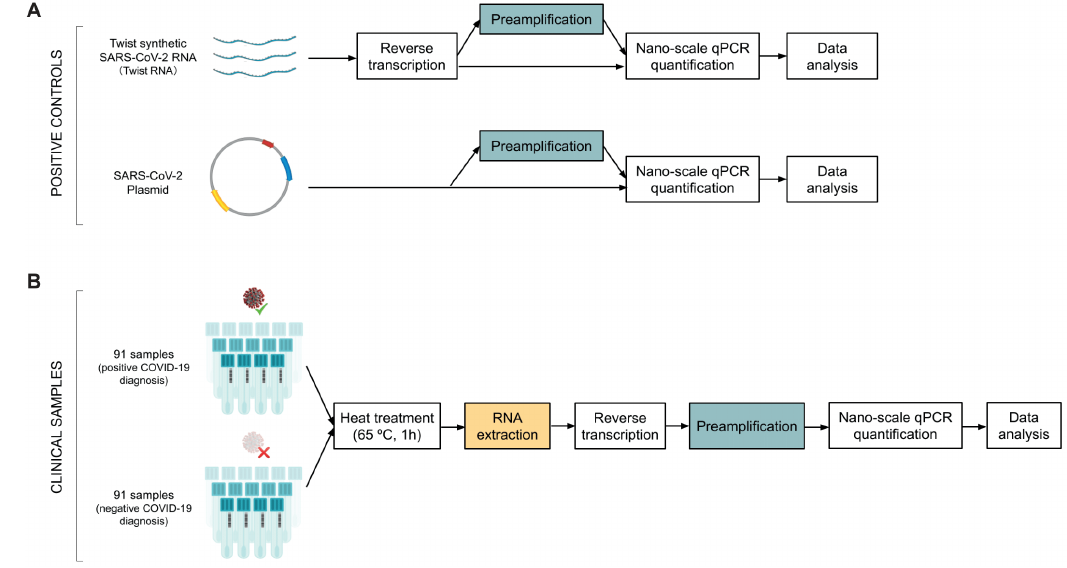
Figure 1. Schematic overview of the experimental design for SARS-CoV-2 RT-qPCR testing using the Fluidigm platform. ( A ) Workflow for method validation in positive controls (SARS-CoV-2 synthetic RNA and SARS-CoV-2 plasmids) with and without a preamplification step. ( B ) Workflow for